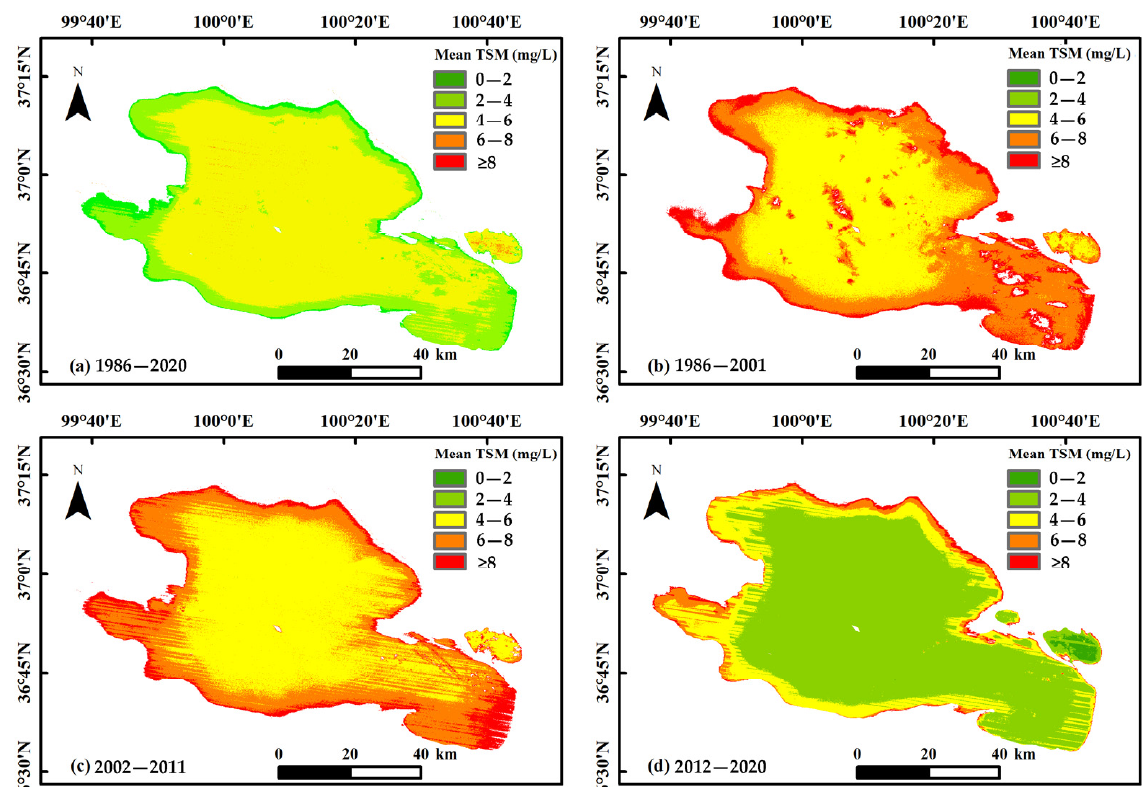
Figure 6. The spatial distribution of mean TSM and changing trend derived from Landsat images during the periods between 1986 to 2020: ( a ) 1986–2020; ( b ) 1986–2001; ( c ) 2002–2011; ( d ) 2012–2020.